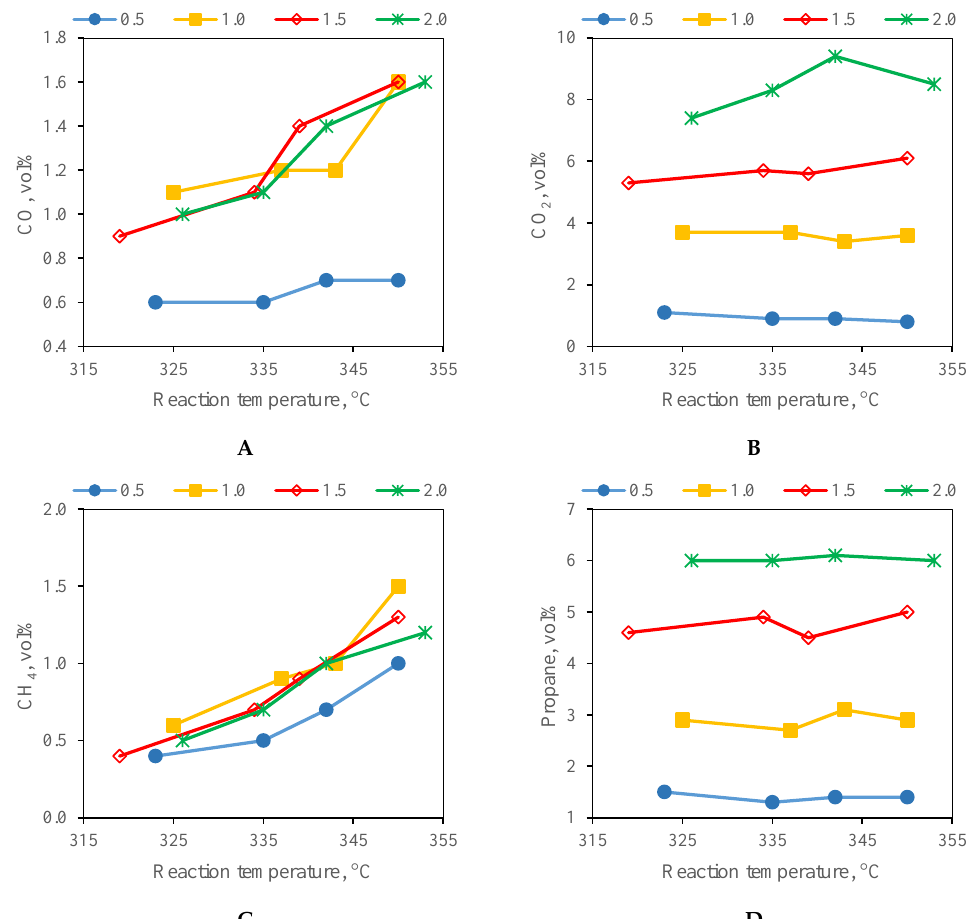
Figure 4. The composition of the P20 gaseous products at WHSV of 0.5–2.0 h − 1 ( A ) carbon monoxide; ( B ) carbon dioxide; ( C ) methane; ( D ) propane.